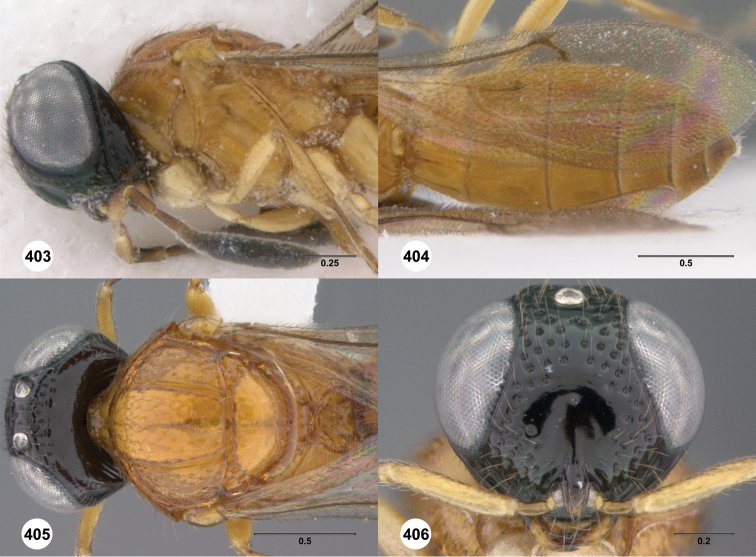
Oxyscelio viator sp. n., holotype female (OSUC 148457) 403 Head and mesosoma, lateral view 404 Metasoma, dorsal view. Paratype female (OSUC 283330) 405 Head and mesosoma, dorsal view 406 Head, anterior view. Morphbank104